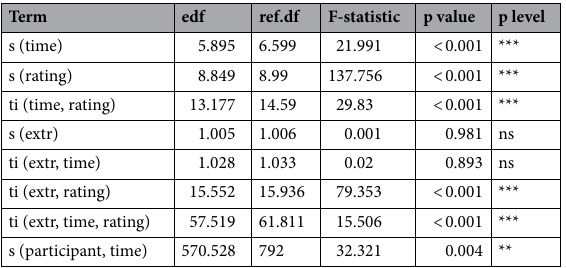
Table 10. Summary output for the GAMM modelling participants’ pupil sizes in response to socio-cultural violations and with their Extraversion score as a predictor.